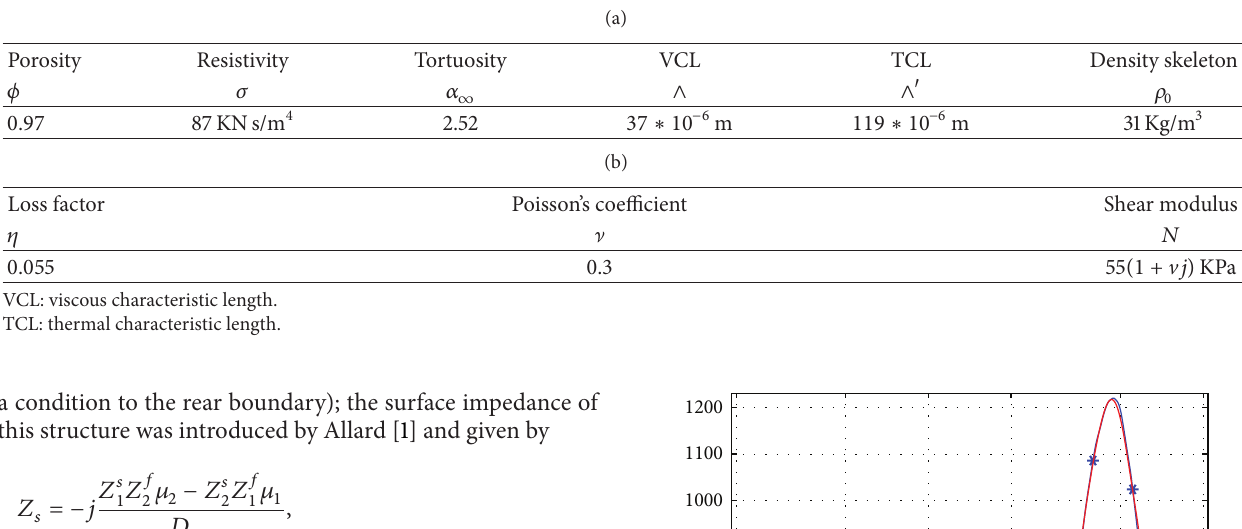
Table 1: Poroelastic properties of polyurethane foam.